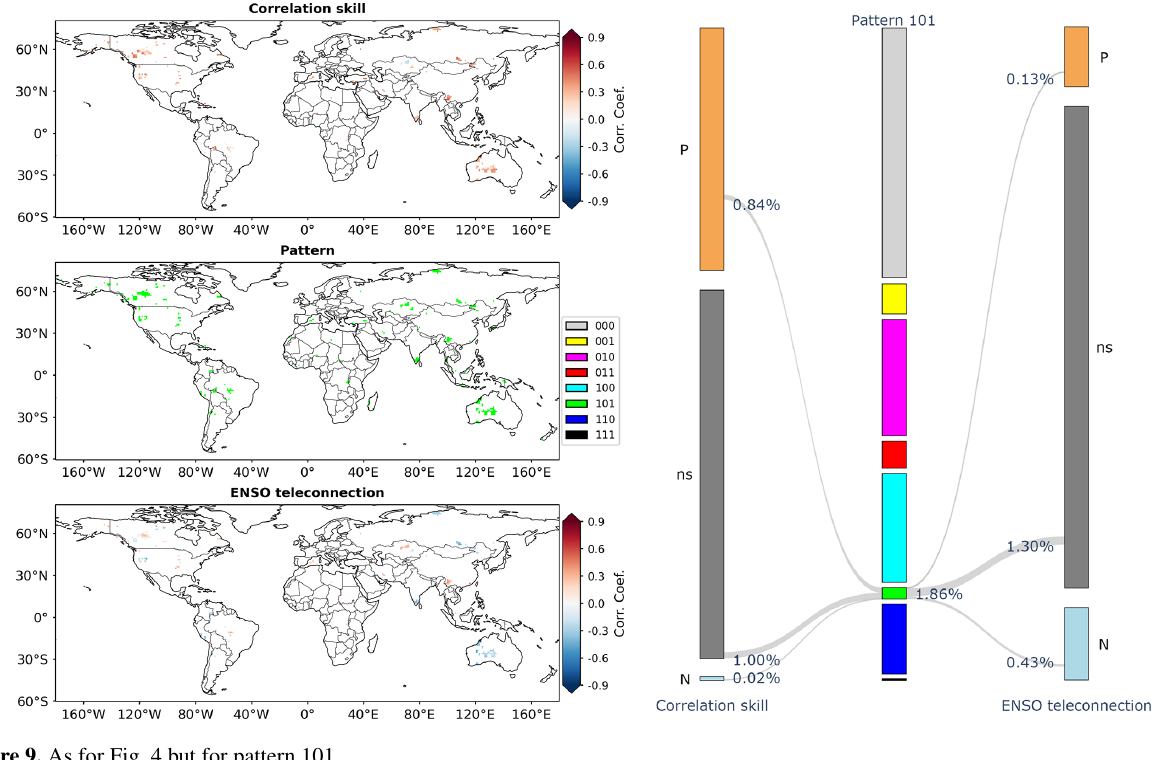
Figure 9. As for Fig. 4 but for pattern 101.